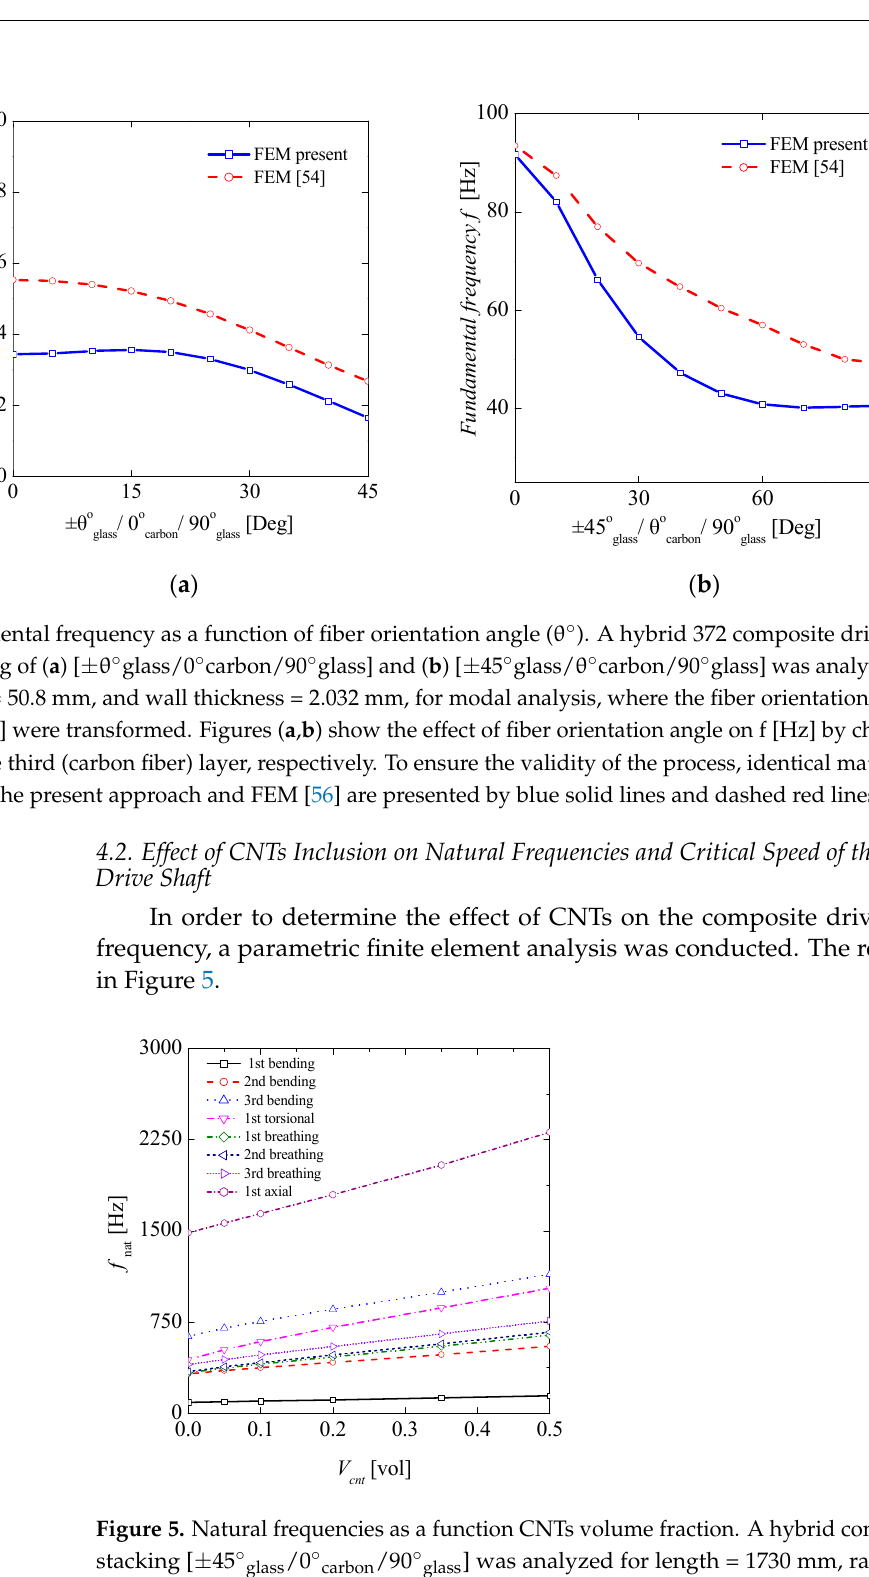
( b ) Figure 6. Critical speed as a function of fiber orientation angle ( θ °) for various CNT volume fractions. A hybrid composite drive shaft having four layers stacking of ( a ) [± θ ° glass /0° carbon /90° glass ] and ( b ) [±45° glass / θ ° carbon /90° glass ] was analyzed for length = 1730 mm, radius = 50.8 mm, and wall thickness = 2.032 mm, where the fiber orientation and volumetric concen- tration of nanoparticles were changed. Figures ( a , b ) show the effect of fiber orientation angle on the critical speed by changing the first two layers and the third (carbon fiber) layer, respectively. The curves show the effect of CNTs volume fractions on the critical speed, computed for CNT volume fractions: 0, 0.05, 0.10, 0.20, 0.35, and 0.50.